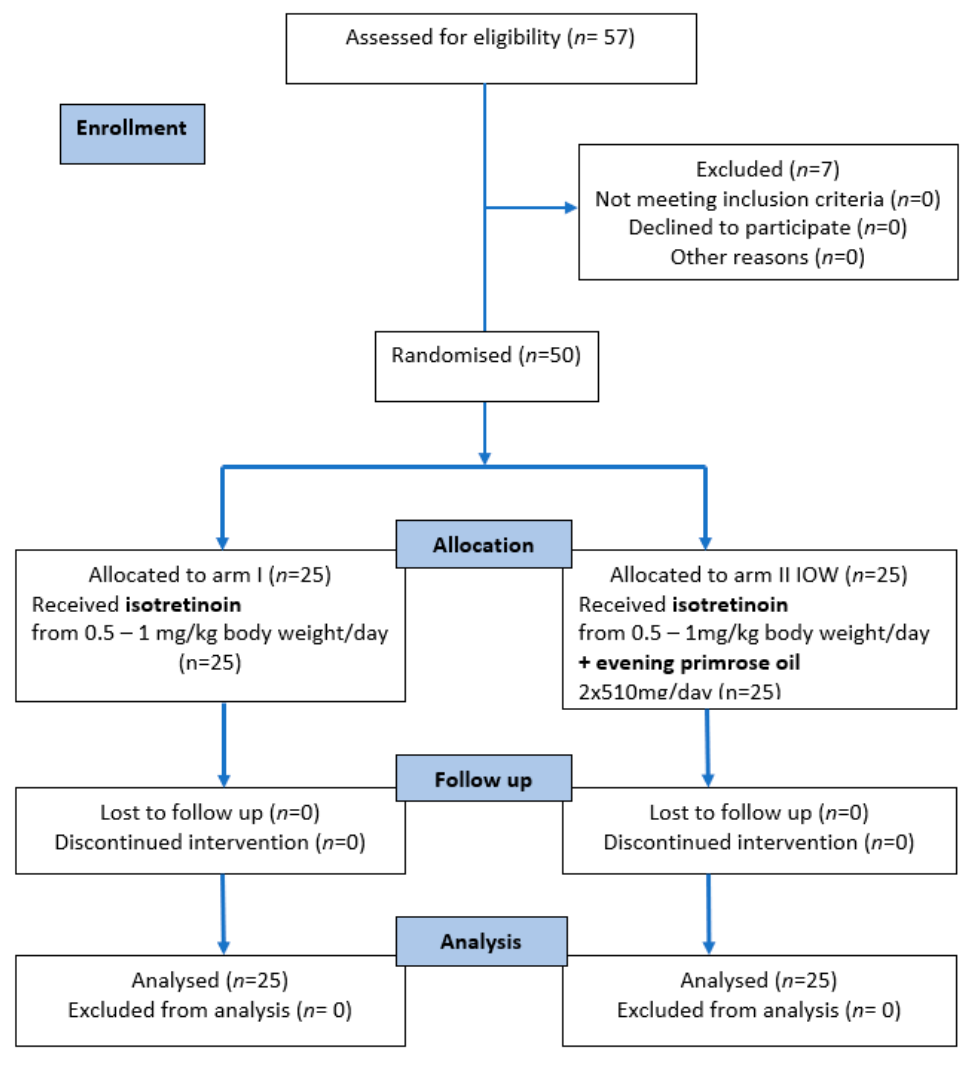
Figure 1. The CONSORT 2010 flow diagram. The baseline characteristics of the study population are shown in Table 2, and in most cases, no differences were observed between subjects assigned to arm I and arm IOW. Differ- ences between groups were found only for HDL ( p < 0.001) and LDL ( p = 0.035)